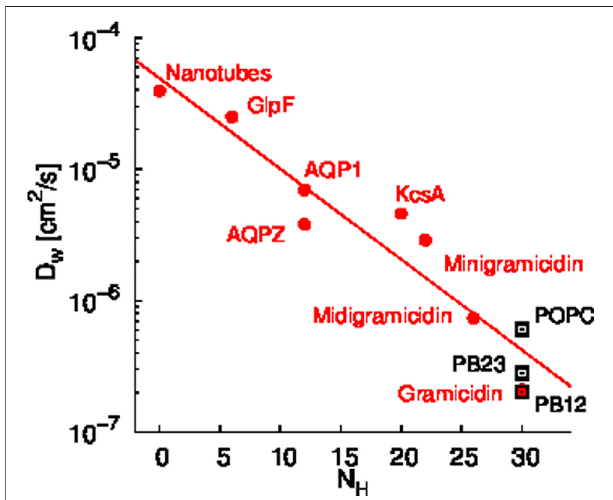
FIGURE 3 | Scaling relationship between the diffusion constant of single fi le water transport (D w ) and the number of hydrogen bonding sites in a given channel (N H ) is shown. Data shown in red circles are from previous studies of several synthetic and biological water channels (Hoomann et al., 2013; Horner et al., 2015; Berezhkovskii and Hummer, 2002; Saparov et al., 2006) and data shown in black rectangles are for PAP in each membrane. The D w values for PAP were computed based on permeability measurements reported in our earlier work (Shen et al., 2018).